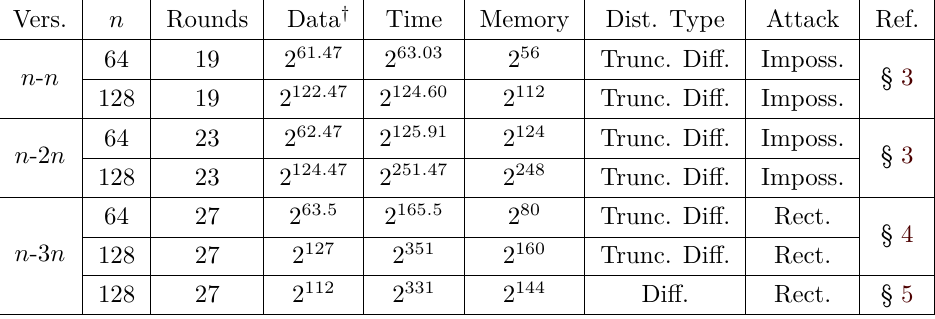
Table 1: Summary of cryptanalytic results on SKINNY